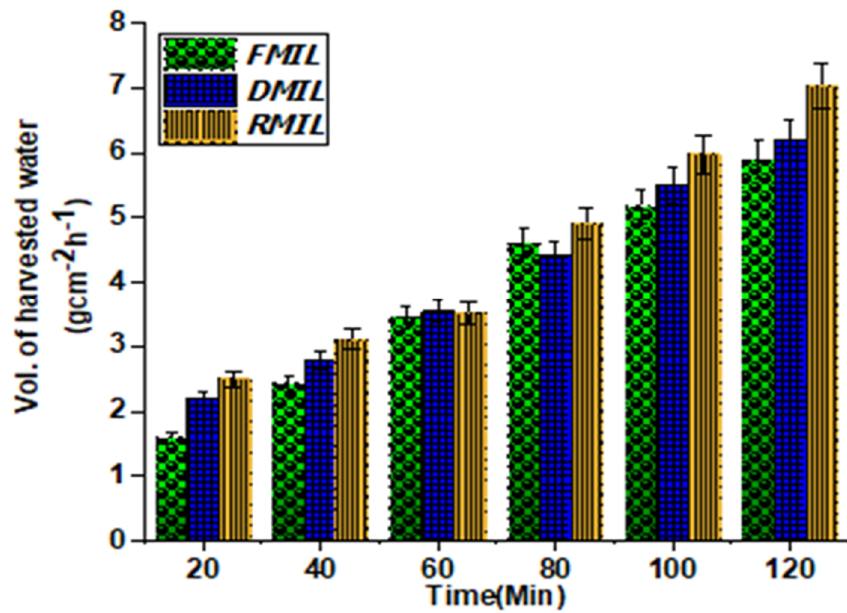
Figure 8. Water collection process from different functional surfaces. Amount of water collected by surfaces exposed to atmospheric water flow for 120 min with 20 min intervals for each cycle. Table 3. Water collection comparison of FMIL, DMIL, and RMIL with other reported surfaces.